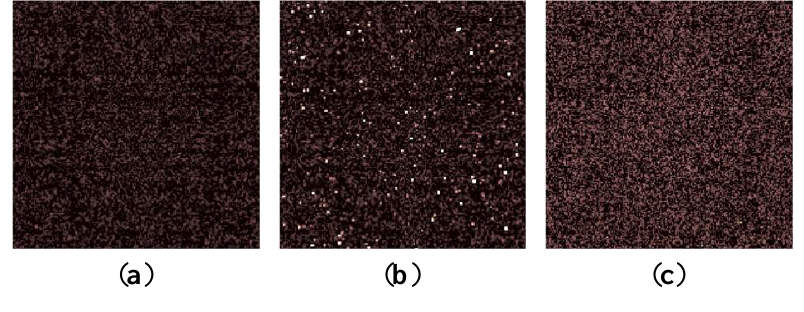
Figure 7. Dark image for different methods. ( a ) Selective averaging. ( b ) Simple averaging. ( c ) Minimum selection. ( d ) Median selection. ( e ) Raw. ( f ) Single aperture